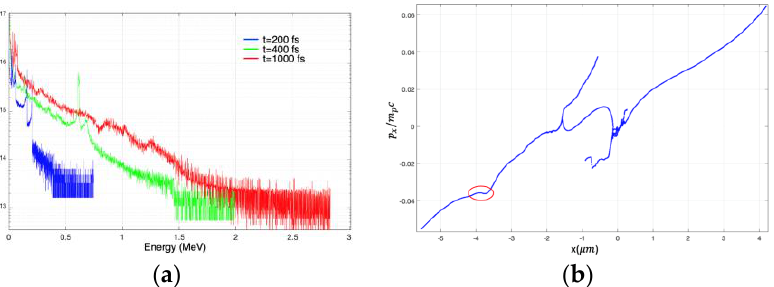
Figure 5. ( a ) Proton energy spectrum for the tailor plus foil at 200 fs, 400 fs, and 1000 fs respectively corresponding to snapshots in Figure 4. The quasi — monoenergetic feature in energy spectrum at 400 fs is explored in the phase plot ( b ) with the region highlighted in red ellipse indicating trapped region.